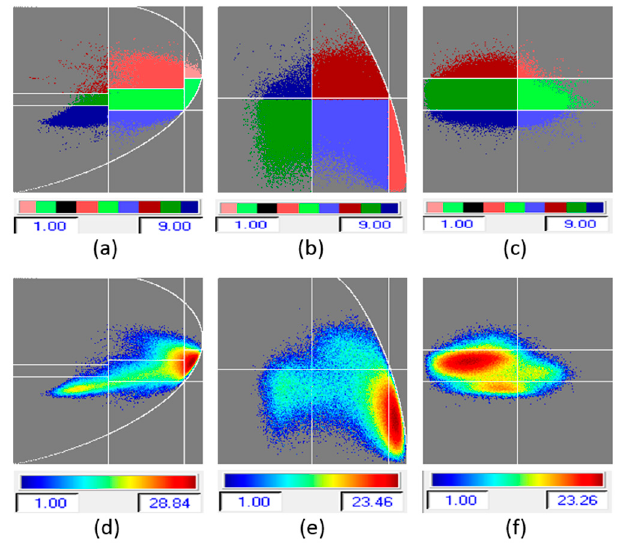
Figure 10. ( a – c ) segmented planes for H/ α , H/A, and A/ α classification; ( d – f ) occurrence planes for H/ α , H/A, and A/ α classification.